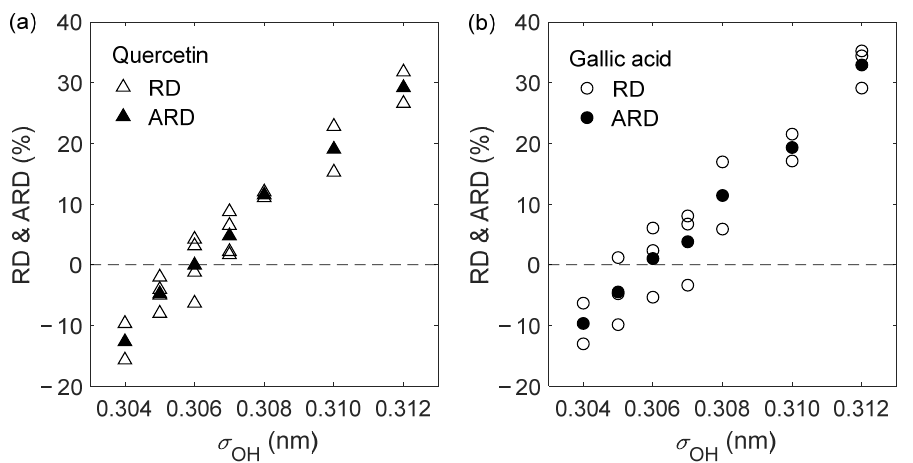
Figure 1. Relative deviations (RD) of D 12 of ( a ) quercetin (triangles) and of ( b ) gallic acid (circles) in liquid ethanol versus ethanol’s oxygen diameter ( σ OH ). Empty symbols are individual RD values at different T and P conditions, while filled symbols are average relative deviations computed from the RD values obtained at each condition.